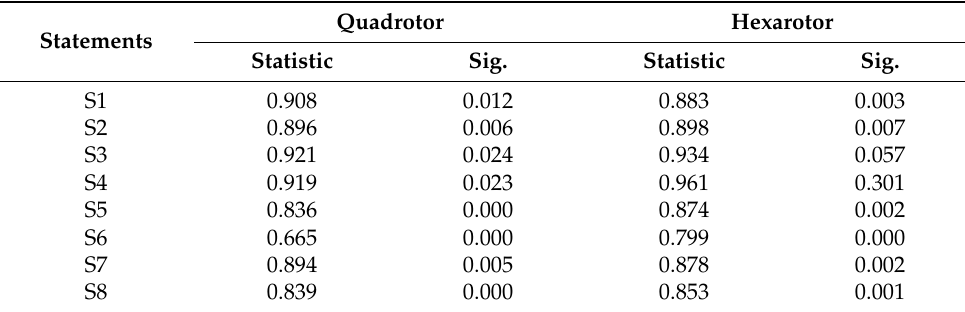
Table 5. Shapiro–Wilk test of normality.